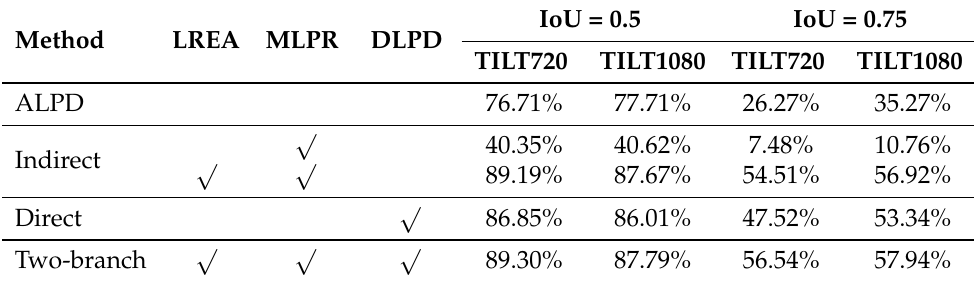
Table 1. Ablation study of different datasets with different IoU thresholds. The values represent the Average Precision (AP) based on the horizontal bounding